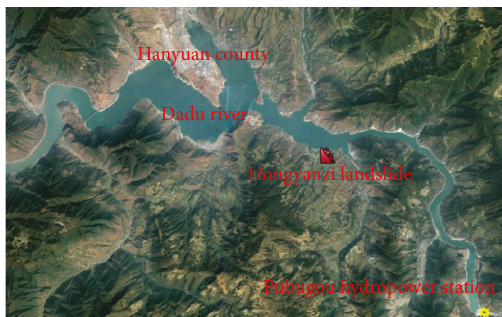
Figure 1: Location map of the Hongyanzi landslide (source: Google Earth).